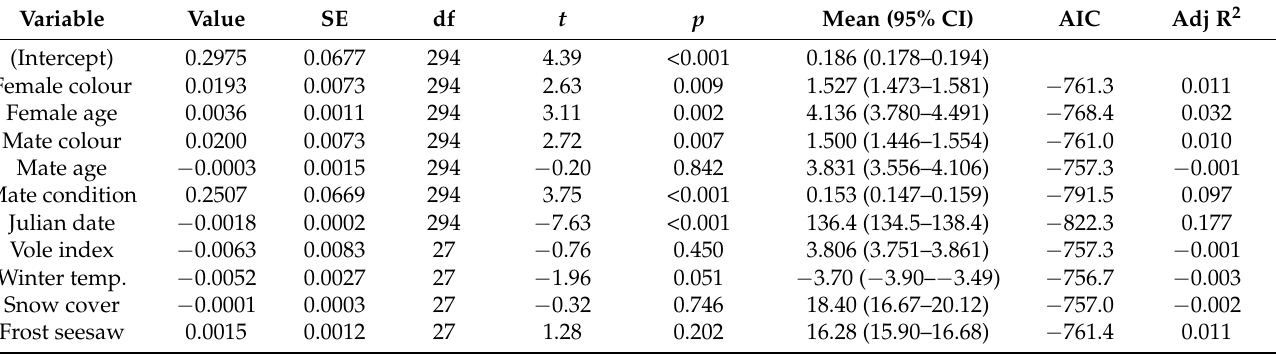
Table 3. Relationships between some intrinsic and extrinsic factors and the body condition of female Tawny Owls Strix aluco near the southern coast of Finland: generalised linear model (glm). The parameter estimates of data (mean and 95% confidence interval) are